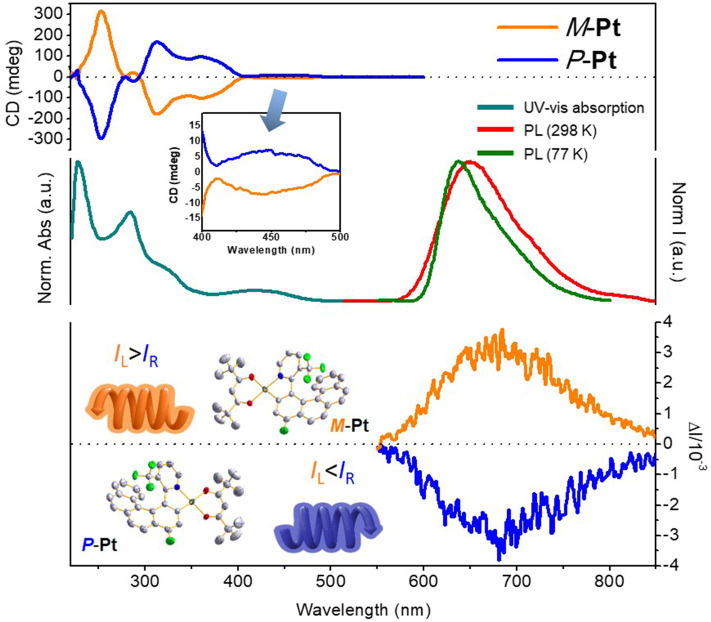
Photophysical properties of platinahelicene in CH2Cl2 (5 × 10−5 mol L−1): (top) CD spectra of P-Pt and M-Pt; (middle) Normalized absorption and PL spectra of (RAC)-Pt; (bottom) CPL spectra of P-Pt and M-Pt.